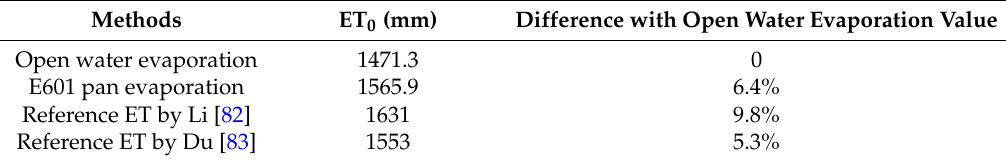
Table 7. Different method to represent lower Heihe River’s annual ET 0